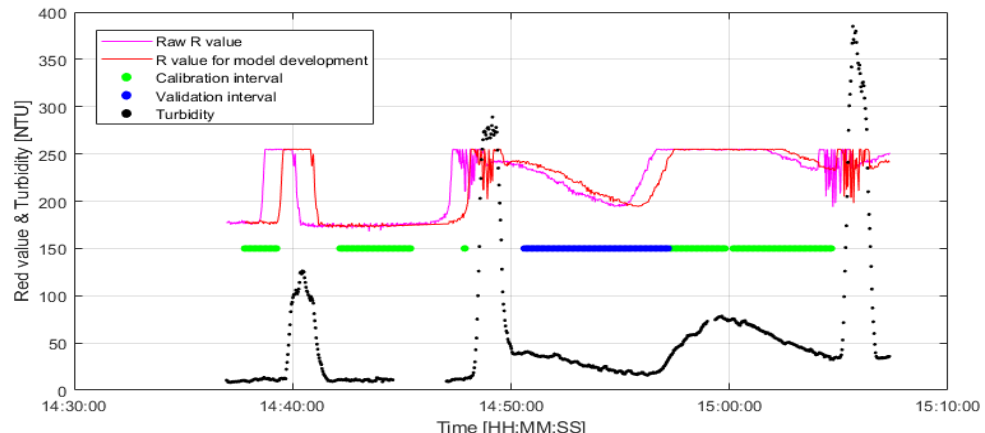
Figure 10. Sections used for model development and verification, and the results reflecting the time difference between the image and turbidity measurement.